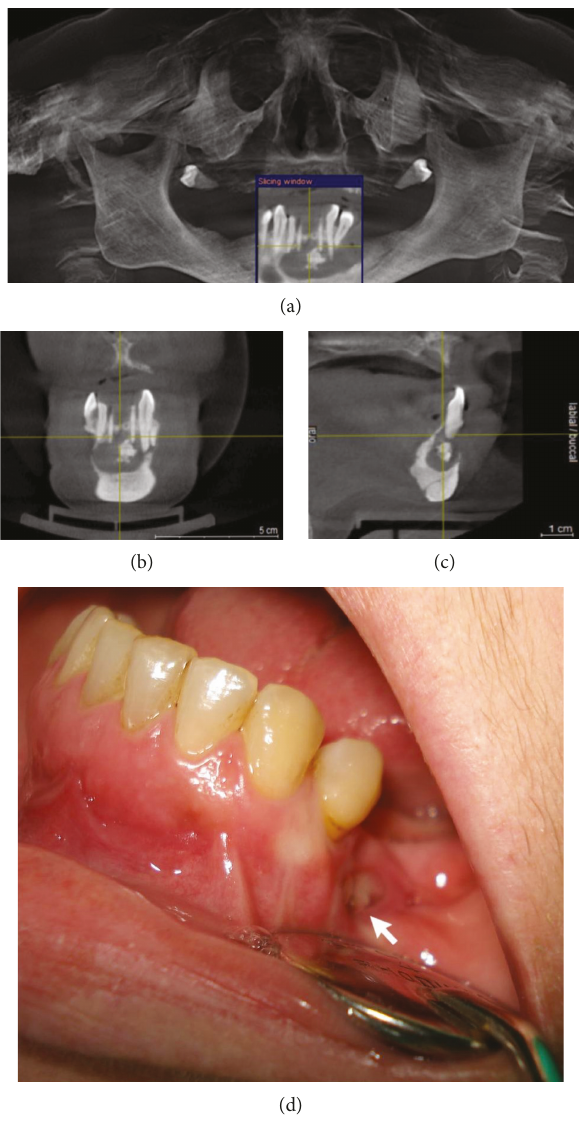
Figure 7: CBCT image: (a) panoramic view, (b) axial view, and (c) cross-sectional view. (d) Fenestration on the mucous membrane.